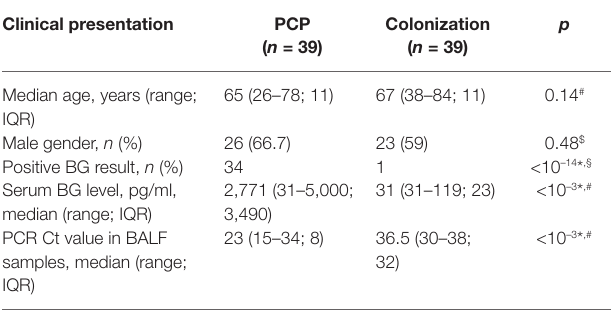
TABLE 4 | Statistical analyses of variables in patients with Pneumocystis pneumonia, according to the underlying condition. Underlying condition